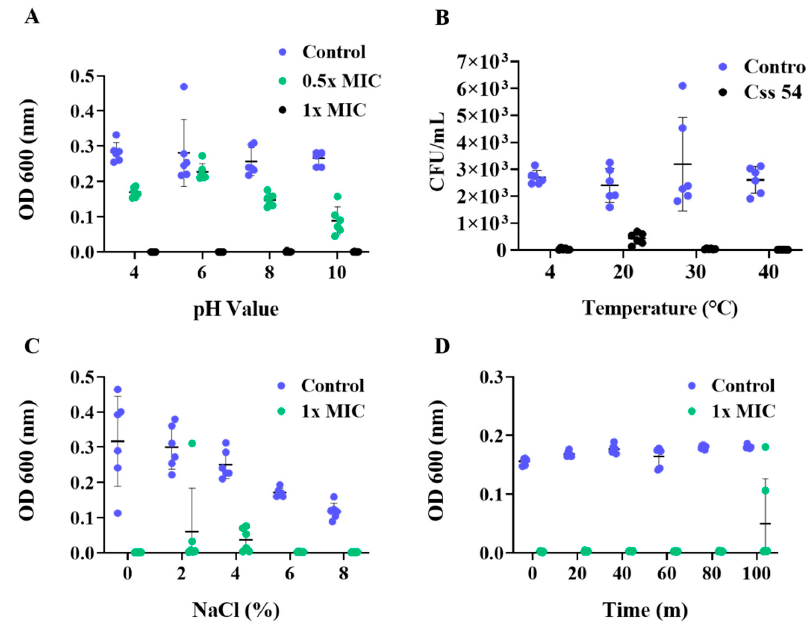
Figure 4. Antimicrobial activity of Css54 in different environments. ( A ) Effect of different pH values, ( B ) salt concentrations, and ( C ) temperatures on antimicrobial activity of Css54. ( D ) To evaluate thermal stability, Css54 at 1 × MIC was incubated for 20, 40, 60, 80, and 100 min and then L. monocytogenes was added to the solution for incubation overnight at 37 ◦